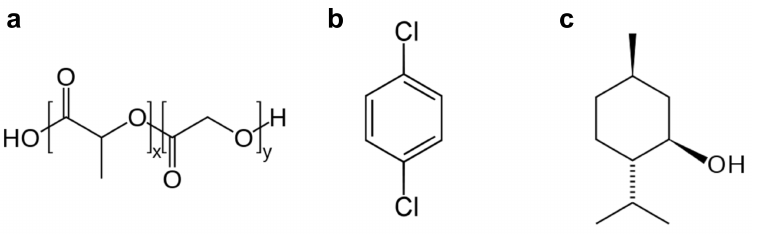
Figure 1. Molecular structures of ( a ) poly(lactic-co-glycolic acid) (PLGA), ( b ) para-dichlorobenzene, and ( c ) ( −